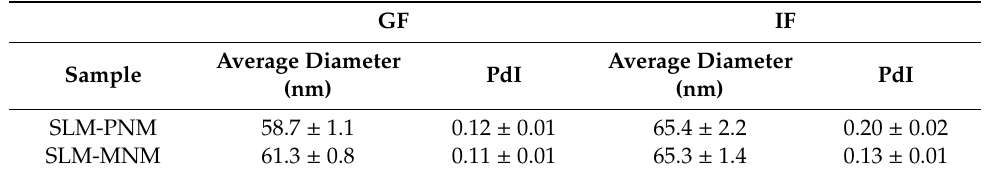
Table 5. Physical stability of SLM-loaded nanomicelles in simulated gastric fluid (GF) and simulated intestinal fluid (IF) (Mean ± SD, n = 3).